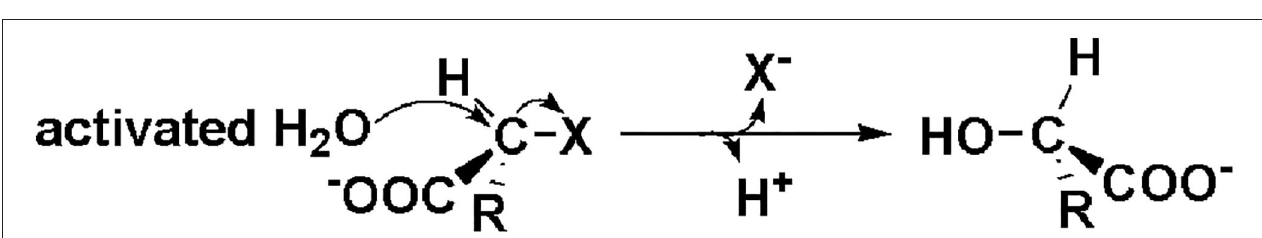
FIGURE 3 | Structural superposition of DehI (green, PDB ID: 3bjx) and DL-DEX Mb (cyan, PDB ID: 4n2x). The active pocket is shown as surface.